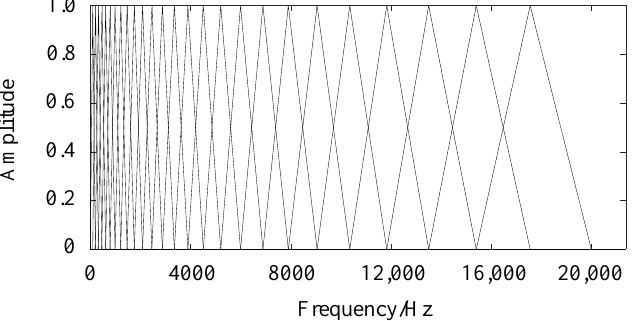
Figure 9. Mel-scale filter banks.